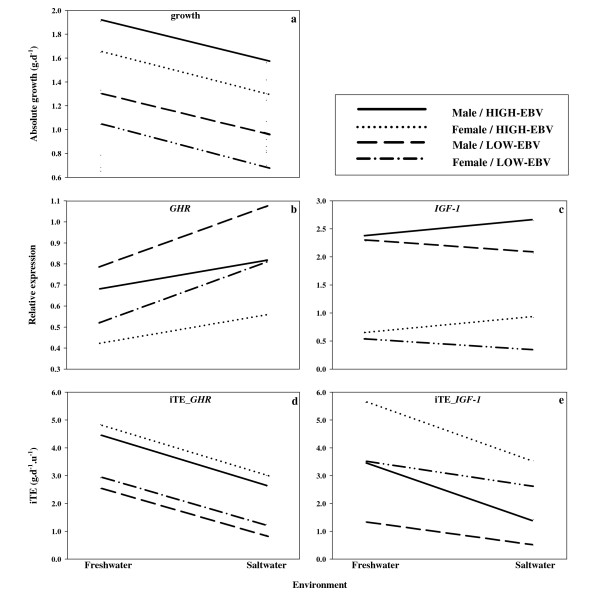
Reaction norm for growth, gene expression and individual transcript efficiencies. Predicted linear means for a) absolute growth, b) relative expression of GHR, c) relative expression of IGF-1 and d, e) individual transcript efficiencies (iTE) for GHR and IGF-1 of males and females of HIGH- and LOW-EBV group reared in freshwater and saltwater (20 ppt) environments. Gene-by-environment interaction between EBVgroup-by-environment for growth and iTEGHR is not clearly illustrated by non-parallel reaction norms because the difference in EBV group within each environment was small, albeit statistically significant.